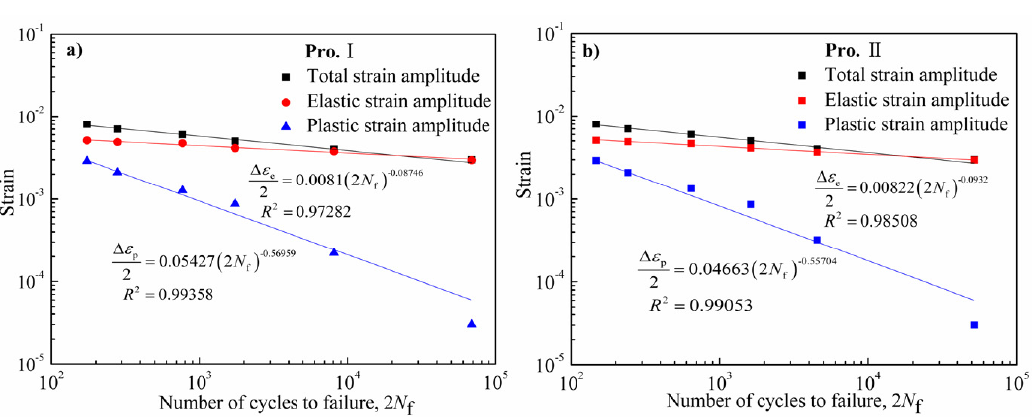
Figure 3. Total; elastic and plastic strain range vs. number of cycles to failure of the nickel-base alloy. ( a ) Pro.I; ( b ) Pro.II.